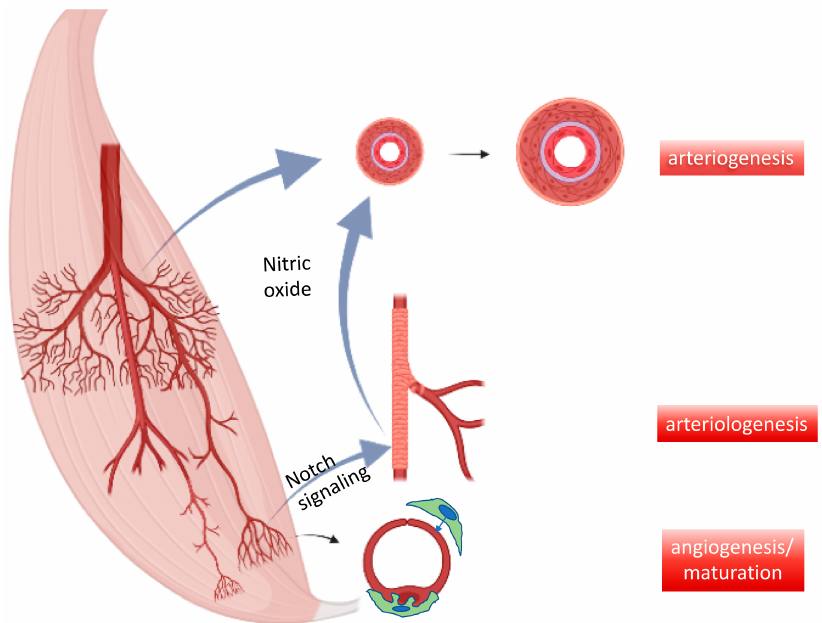
Figure 4. Interdependence of micro- and macrovessel growth. Key mechanisms of vessel growth in devel- oping and adult organisms include capillary formation and stabilization by pericytes (=maturation) as well as resistance control by newly added smooth muscle cells to arteriolar endothelial cells